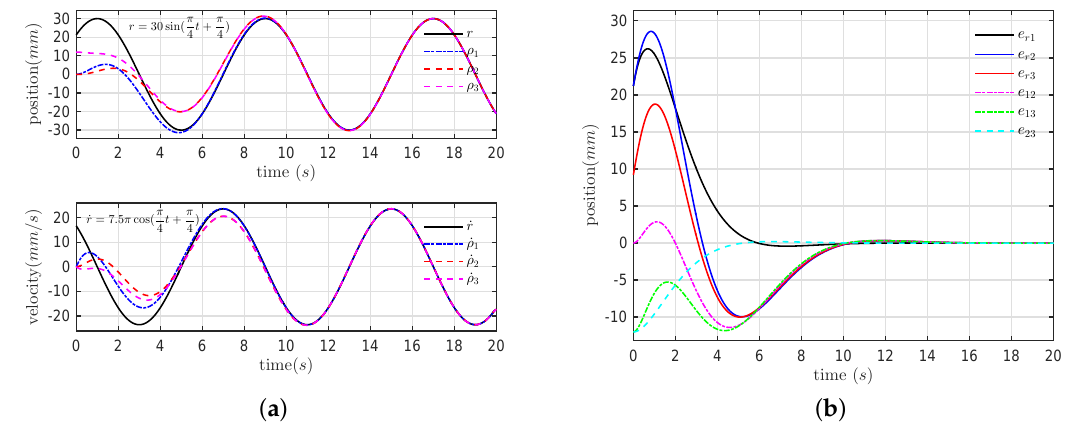
Figure 5. ( a ) Position and velocity response and ( b ) relative position error